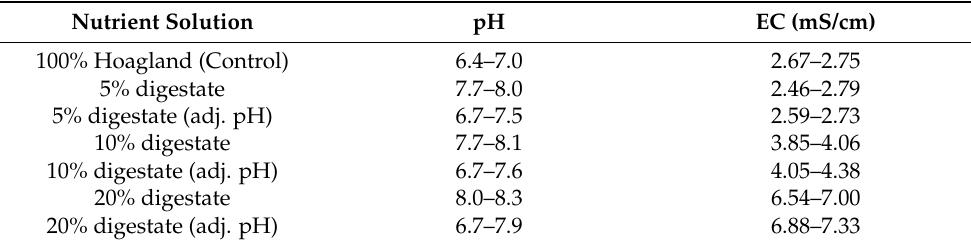
Table 2. Average pH and EC for each nutrient solution during the experimental